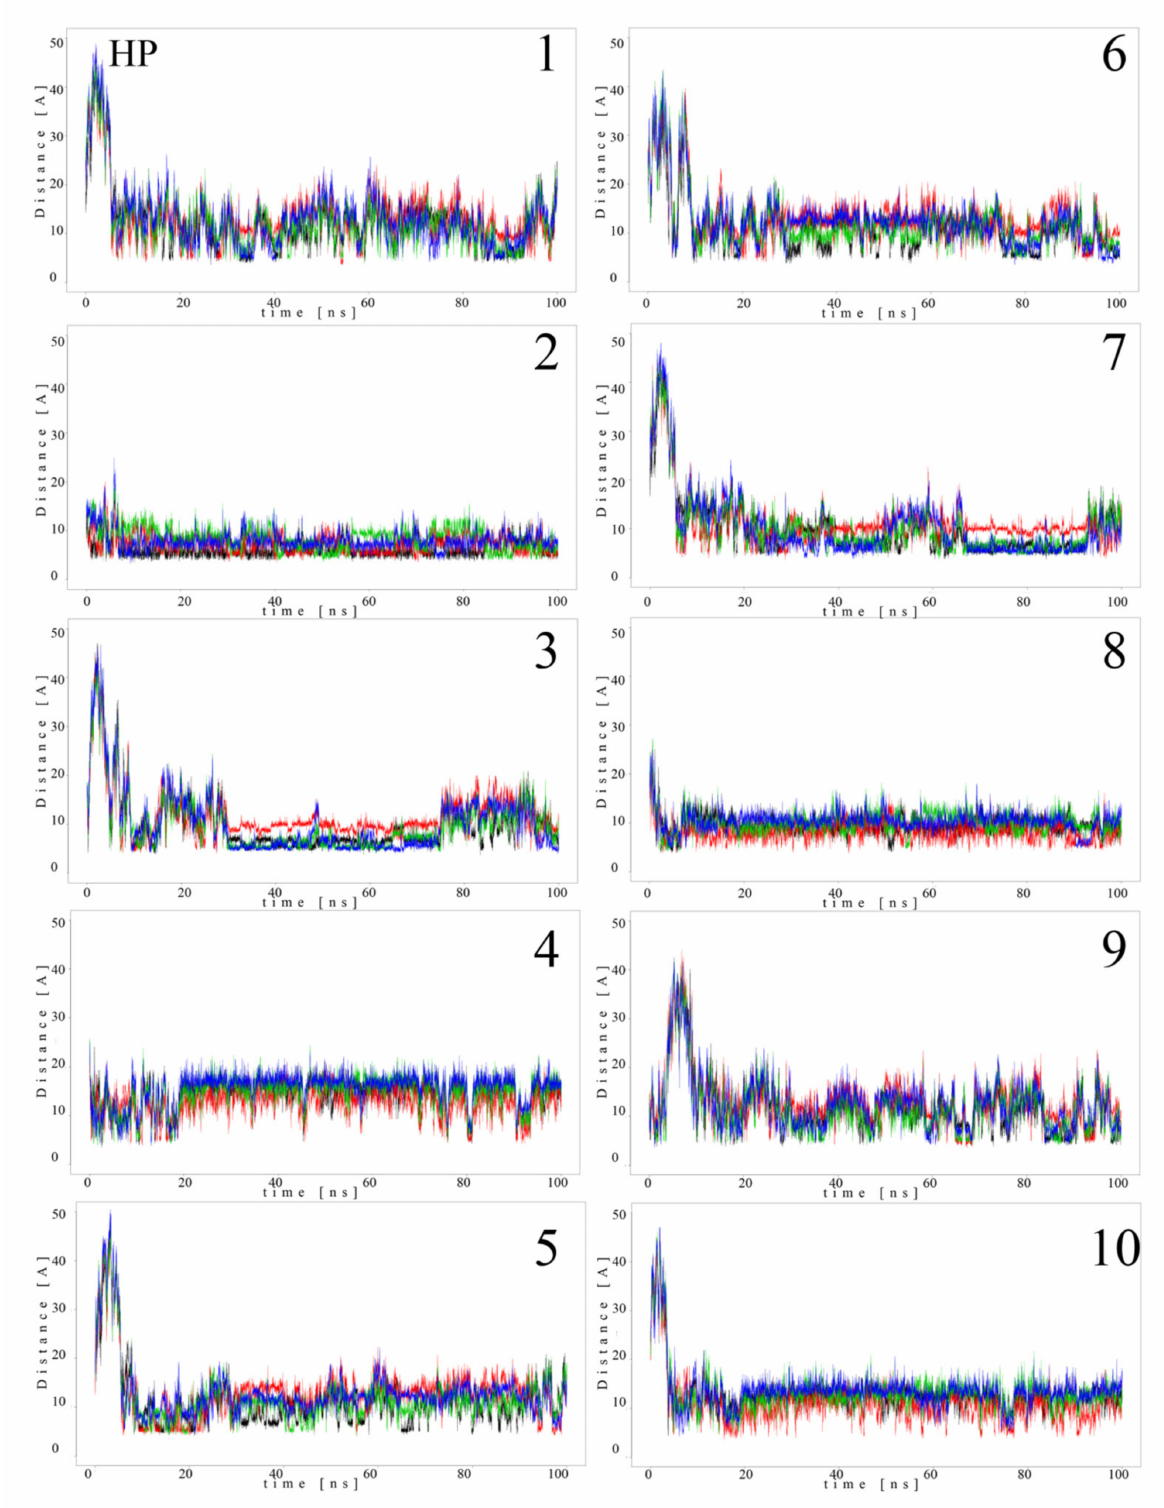
Figure 5. Distances (Å) between HP dp10 sulfate groups (corresponding sulfur atom), the carboxylate group (corresponding carbon atom) and one of the nitrogen atoms from the dimethylamino moieties of MB molecules ( 1 – 10 ) during MD (HP: black, glucosamine N -sulfates; blue, glucosamine 6- O - sulfates; red, iduronic acid 2- O -sulfates; green, carboxylate